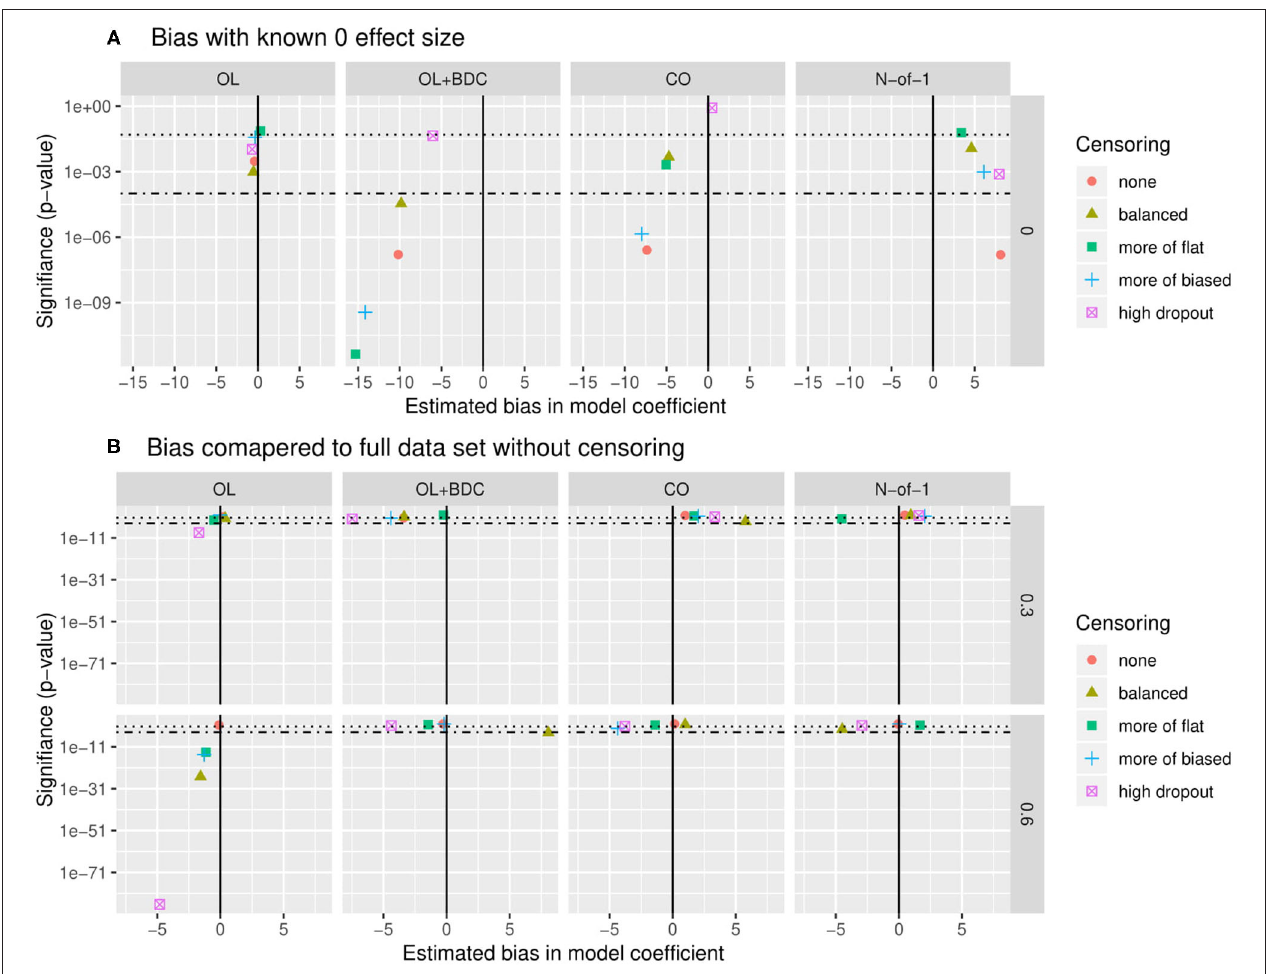
FIGURE 7 | Quantification of bias in effect size estimate as a function of trial design and censoring parameters. (A) Bias in model coefficient for interaction term being used for hypothesis testing ( β ) quantified as the mean coefficient across simulated replicates when the true effect size was set to zero (estimated bias in model coefficient). P -value (y axis) indicates results of a two-tailed, one-sample t -test comparing the coefficients across the set of replicates to µ = 0. (B) Bias in model coefficient for interaction term being used for hypothesis testing quantified as the mean difference ( 1 β ) between the coefficient for a single replicate ( β ) and the “gold standard” coefficient for that parameter set ( β t ), with the “gold standard” defined as the coefficient calculated across all simulated participants from all replicates with no censoring. P -value (y-axis) indicates results of a two-tailed, one-sample t -test comparing the 1 β across the set of replicates to µ = 0. Dotted line indicates p = 0.05, dot-dash line indicates p = 0.0001. β and 1 β values multiplied by 1,000 for ease of visualization. OL = open label, OL + BDC = open label followed by blinded discontinuation, CO = cross over, N-of-1 = proposed N-of-1 trial